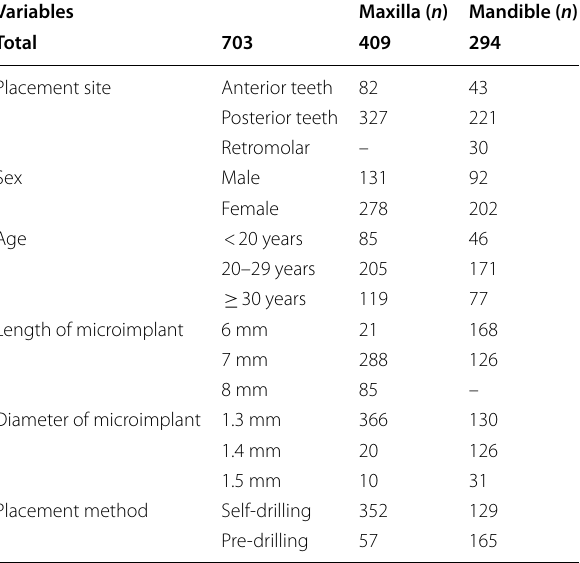
Table 1 Variables and number of microimplants Variables